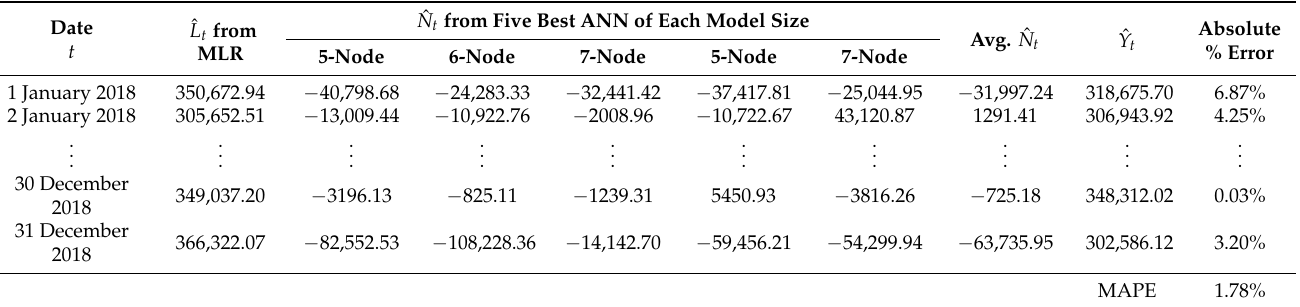
Table 10. Hybrid model of MLR and five best ANN of all model sizes.